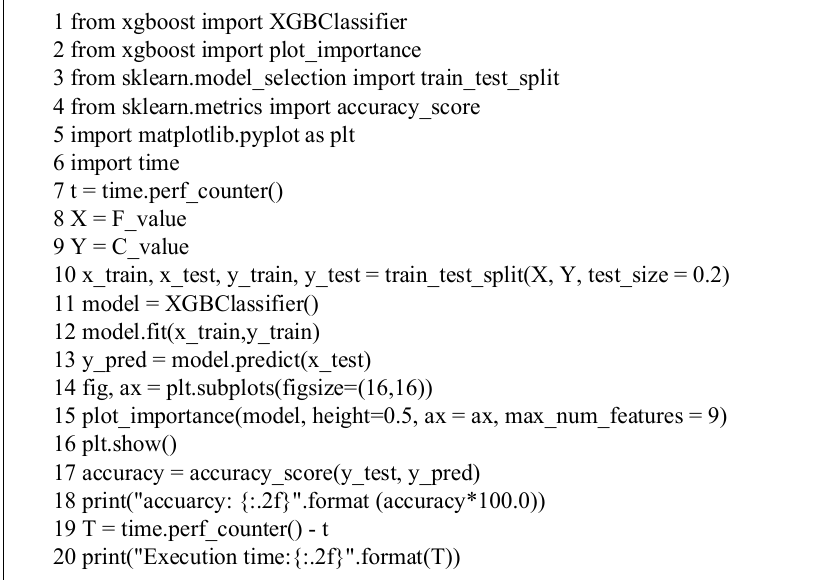
Figure 2. Implementation code of false epidemic information identification based on classifier XGBClassifier.